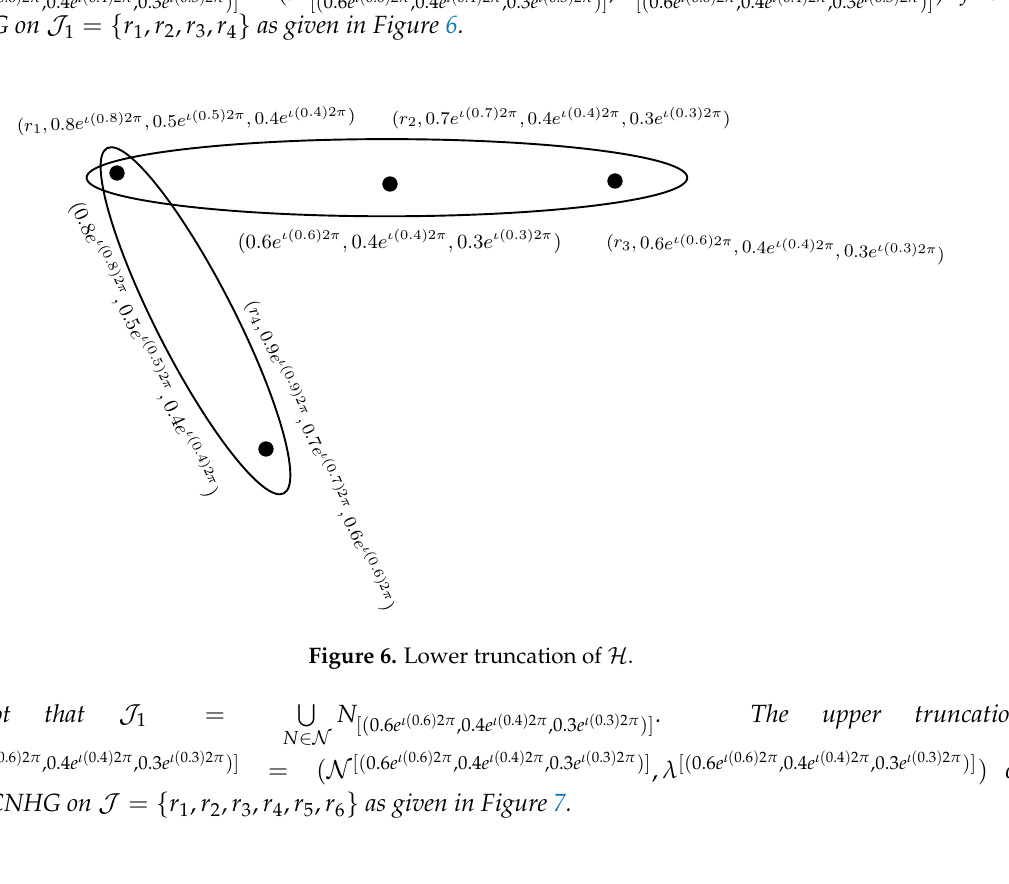
Figure 6. Lower truncation of